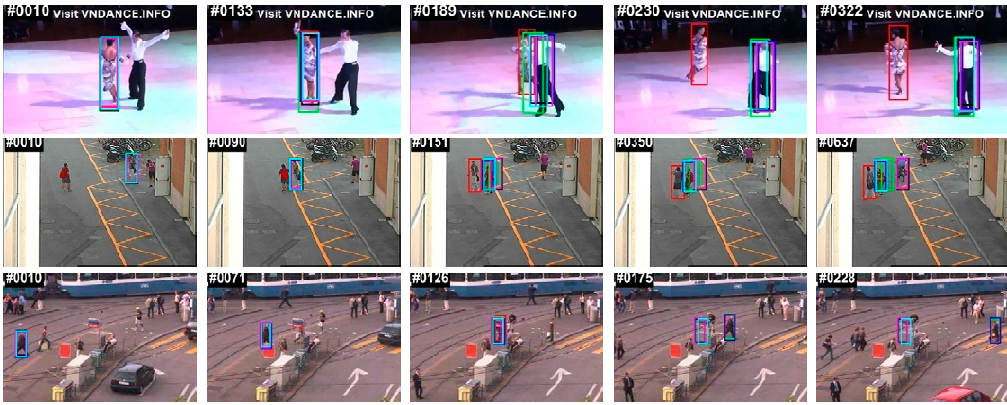
Figure 7. Qualitative analysis of three challenging sequences (Latin, Ped2 and Ped1) using the MEEM dataset. Ours, SAMF, LCT, fDSST, KCF and DSST.